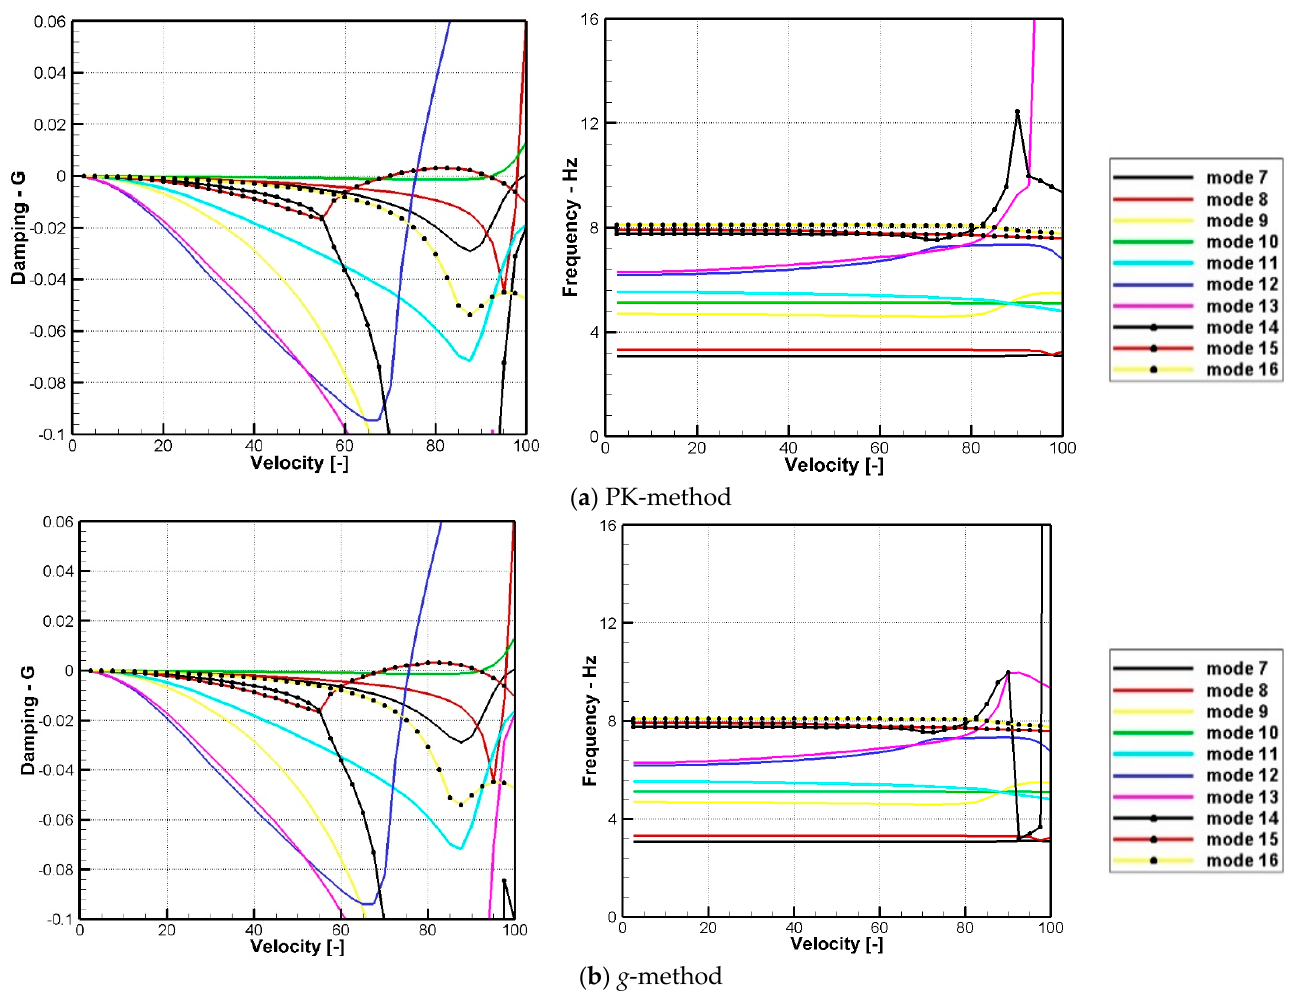
Figure 11. Results comparison between the FLUTQ g - and PK-methods for the Symmetric 2 configuration of the real-world jet aircraft with velocities arbitrarily normalized.